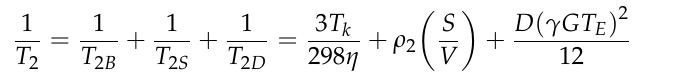
Figure 1. Pore morphology characteristics of the selected coals by SEM measurement.